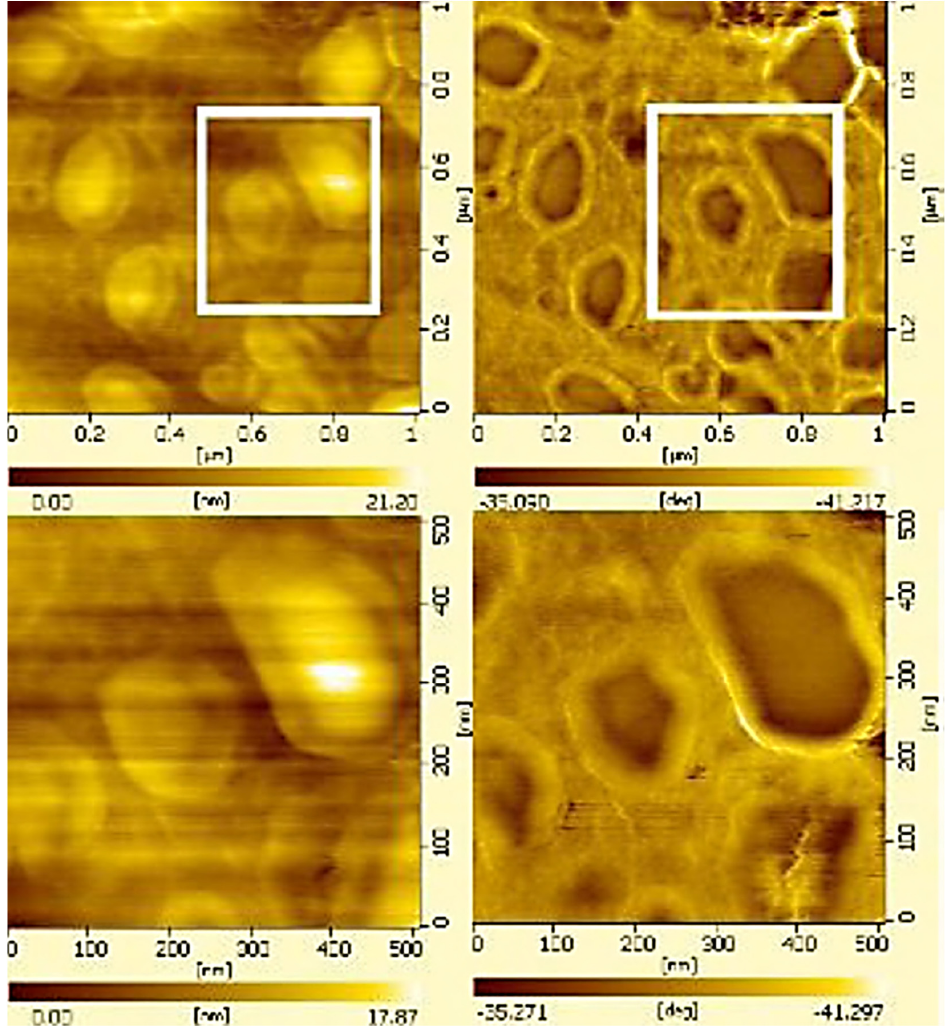
Figure 7. AFM images of P3HT/re-mGO nanocomposites (5 mg/mL) with plan images ( left ) and phase images ( right ) [85]. P3HT/re-mGO = poly (3-hexylthiophene)/reduced modified graphite oxide.